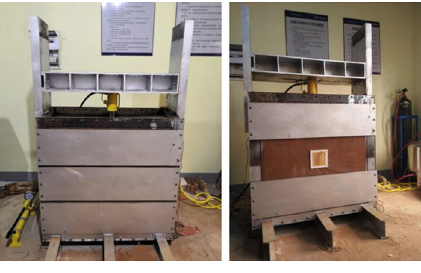
Figure 7: Model test